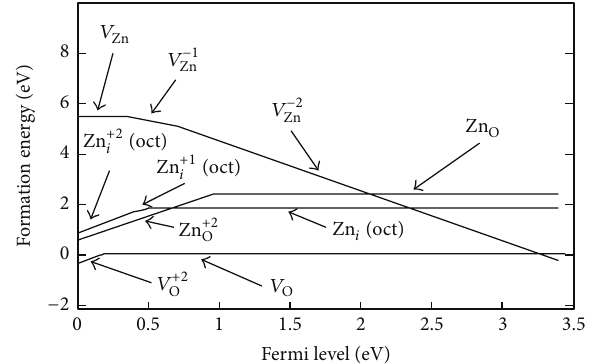
Figure 1: Calculated defect formation energy for selected defects = 𝜇 ZnO (high zinc as a function of the Fermi level and for 𝜇 Zn partial pressure). Only the lowest formation energy values are Figure 3: Formation energy of interstitial hydrogen in ZnO as a shown. The zero of the Fermi level is set to the top of the valence function of Fermi level, obtained from DFT-LDA calculations and band. Reprinted with permission from [13]. Copyright 2000 by the referenced to the energy of a free H 2 molecule. Zero-point energies American Physical Society. are included. The zero of Fermi energy is chosen at the top of the valence band. Reprinted with permission from [14]. Copyright 2001 by Elsevier Science